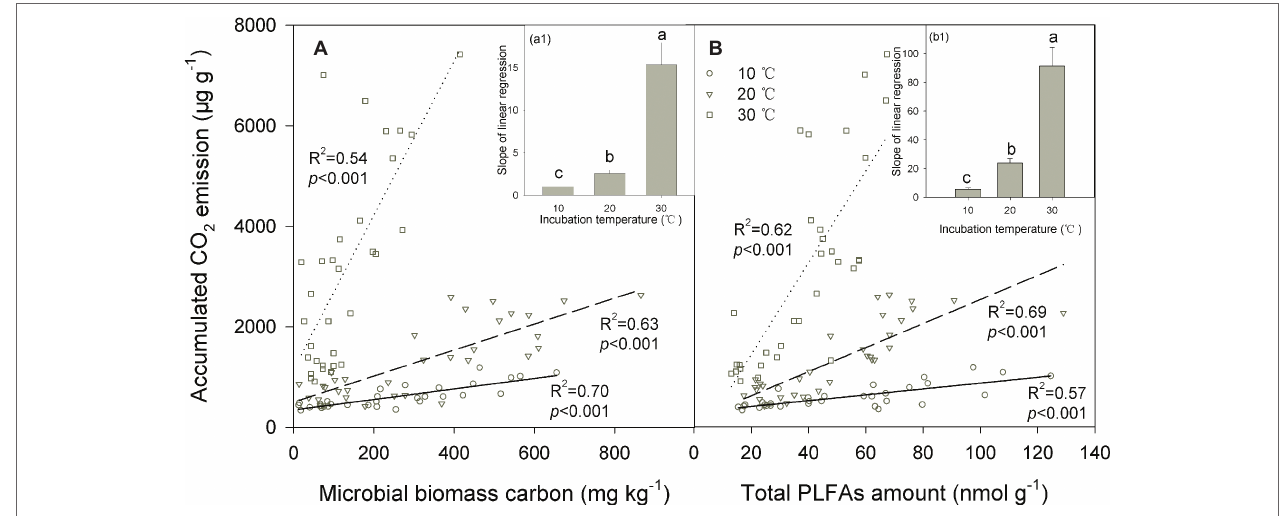
FIGURE 4 | Linear relationship between the accumulated amount of soil CO 2 emissions and microbial biomass carbon (A) and the total amount of phospholipid fatty acids [PLFAs (B) ] under different incubation temperatures, with the inserted panels A1 and B1 presenting the slopes of linear regressions under the three incubation temperatures. In the figure, the solid lines are regression lines between the two variables observed at 10 ° C, while the dashed and potted lines are those at 20 and 30 ° C, respectively. The coefficient of determination R 2 and significance level p are presented for each incubation temperature. Different lowercase letters above the bars in the inserted panels A1 and B1 indicate significant differences among the